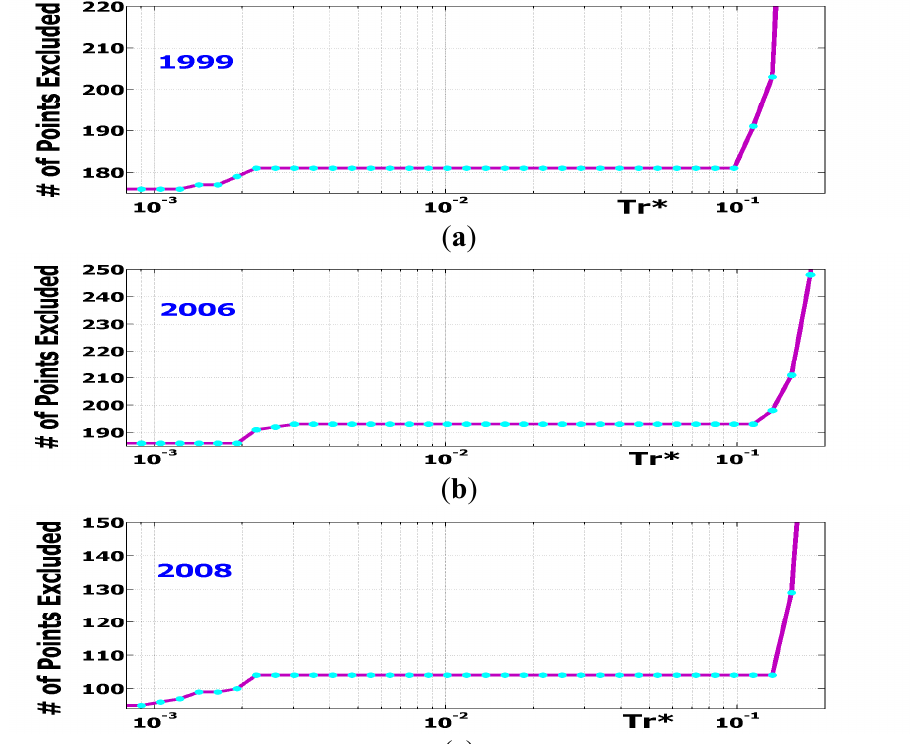
Figure 5. Number of screened points as a function of specified transmittance threshold (Tr*) for three years: 1999 ( a ), 2006 ( b ) and 2008 ( c ). For the selected threshold (Tr* = 0.01) the number of screened points is 181, 193 and 104 for these years, respectively. The improved version with the selected threshold (Tr* = 0.01) removes